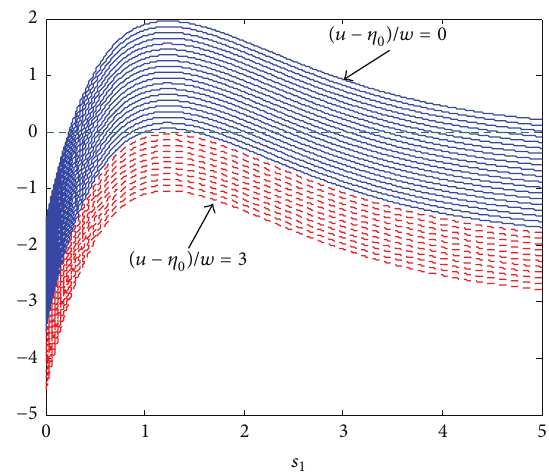
Figure 4: Visualization of OSTP equation with 10 equally spaced )/𝑤 between [0 3] for 𝑡 𝑓 values of (𝑢 − 𝜂 0 = 5 , 𝑠 = [ 0 5 ] 𝜏 𝑠 1